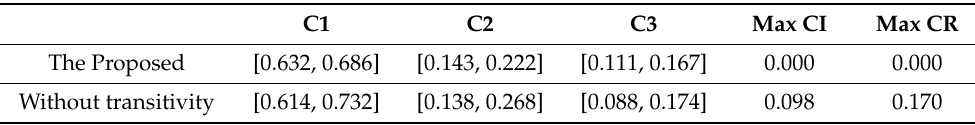
Table 3. Fuzzy weights derived from the consistent FPCM in Example